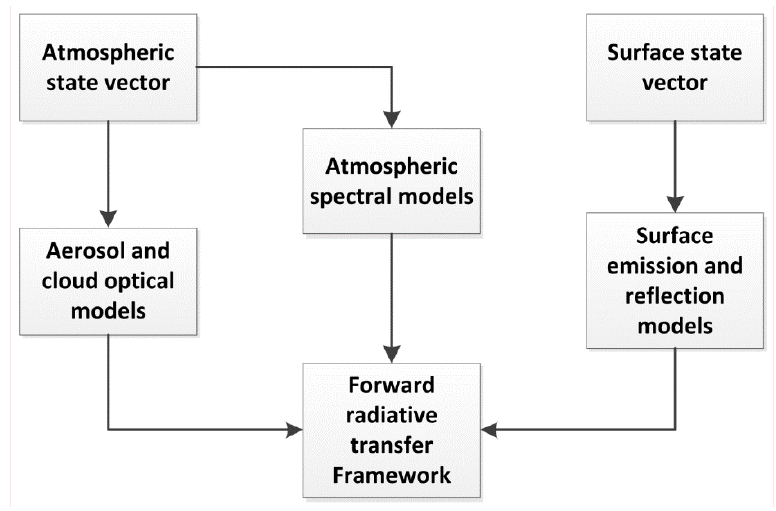
Figure 1. Schematic diagram of the community radiative transfer model (CRTM) radiative transfer model.